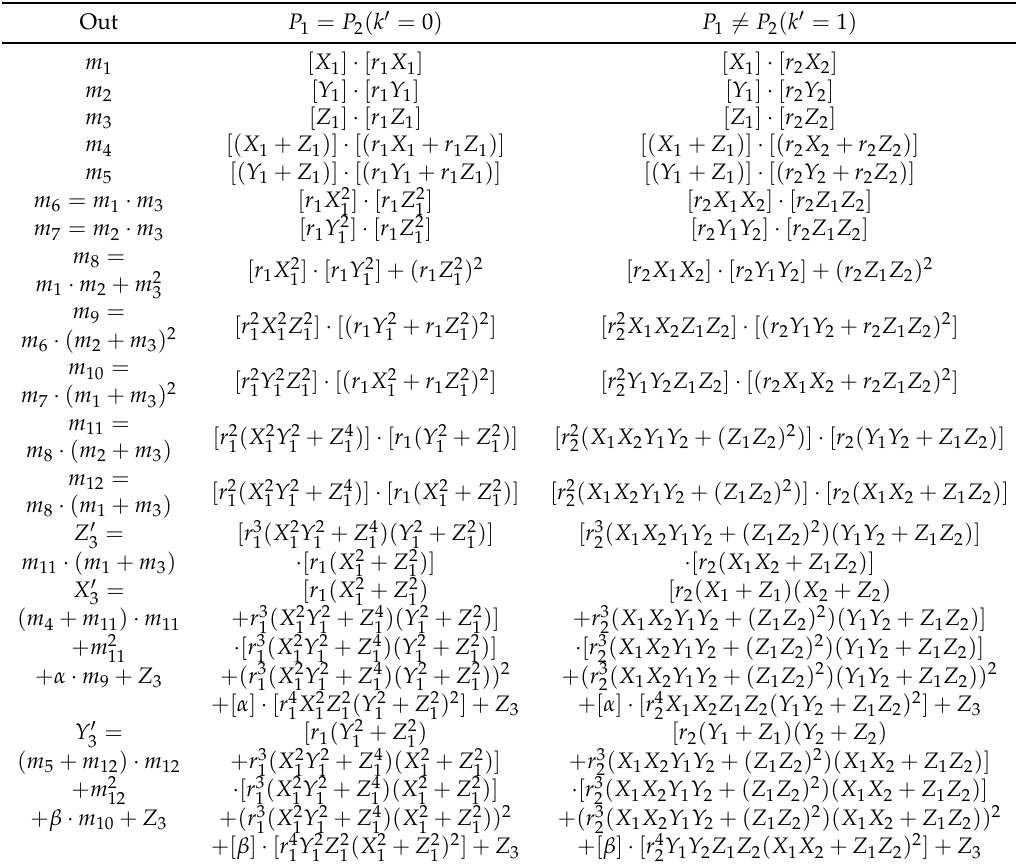
Table 2. The proposed unified point addition method on the binary Huff curve in Algorithm